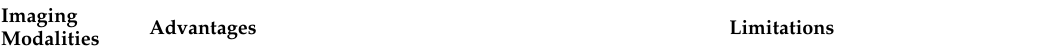
Table 1. Advantages and limitations of various imaging